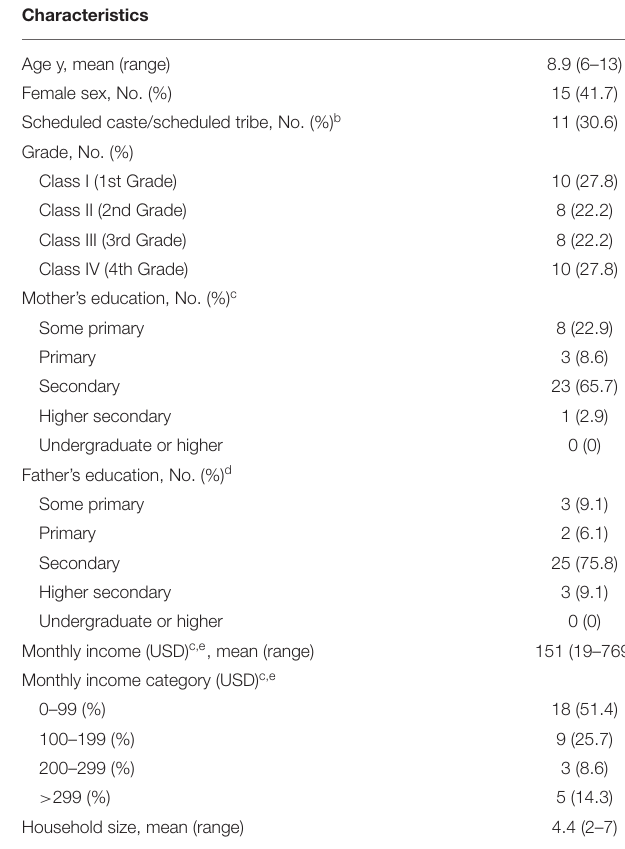
TABLE 4 | Demographic Characteristics of Participating Teachers ( n = 23) a . TABLE 5 | Demographic characteristics of participating children ( n = 36) a